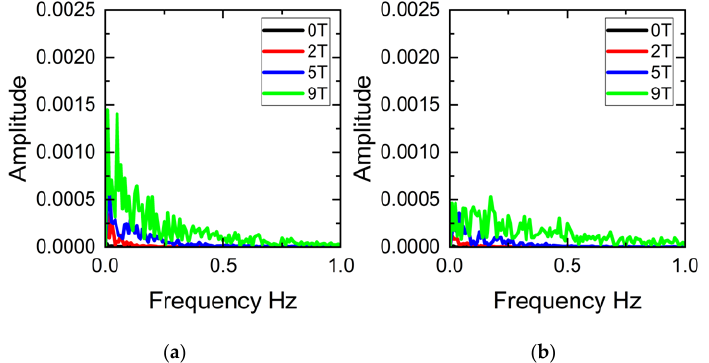
Figure 13. Fast Fourier transform results for the velocity components u ( a ) and v ( b ) for the case with ΔT = 5 °C.